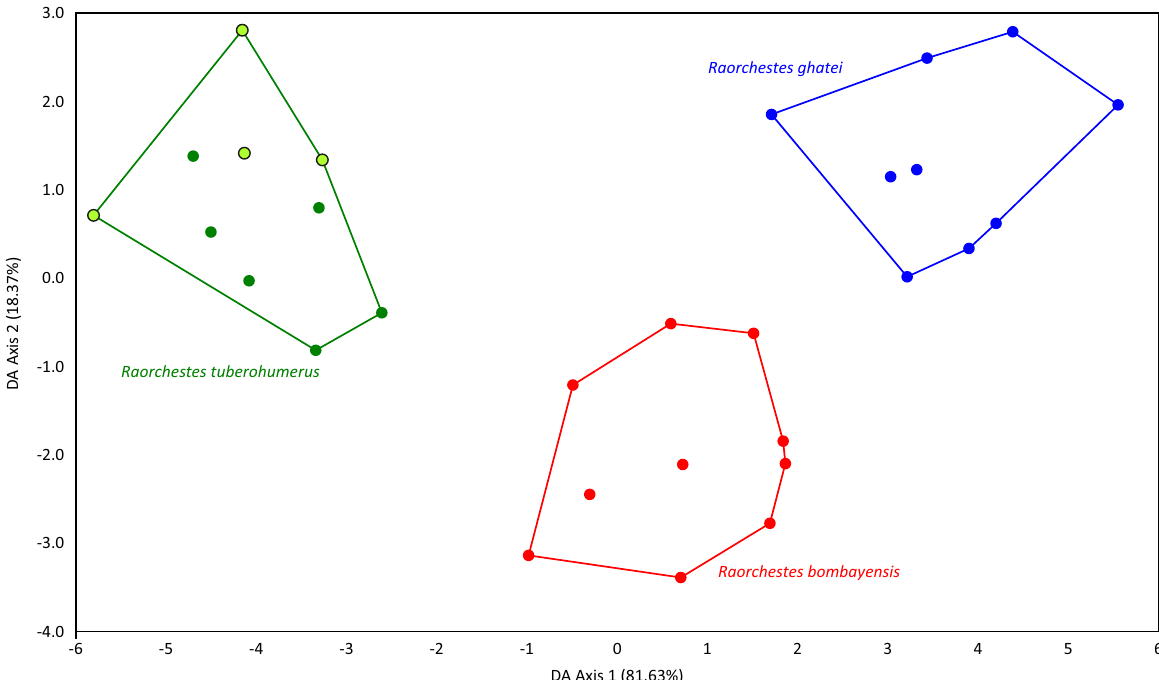
Figure 2. Discriminant Analysis of morphological data of males of the three closely related species showing that the males in the current study are conspecific with Raorchestes tuberohumerus . Light green circles with black border are the male specimens within the R. tuberohumerus